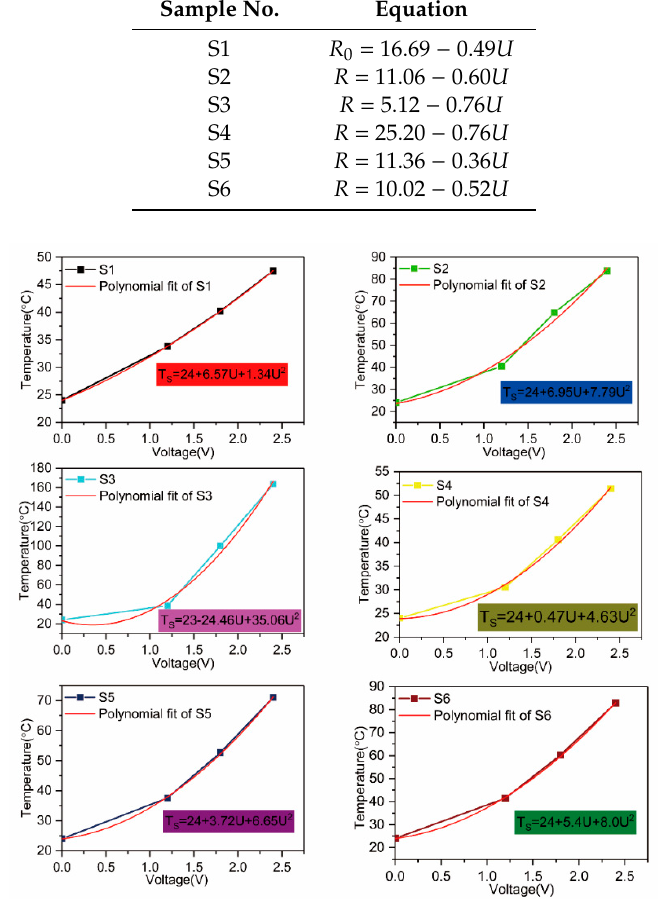
Figure 9. The experimental data and simulation data curves of temperature versus voltage ( T – U ) of S1–S6 at 1.2, 1.8, and 2.4 V.